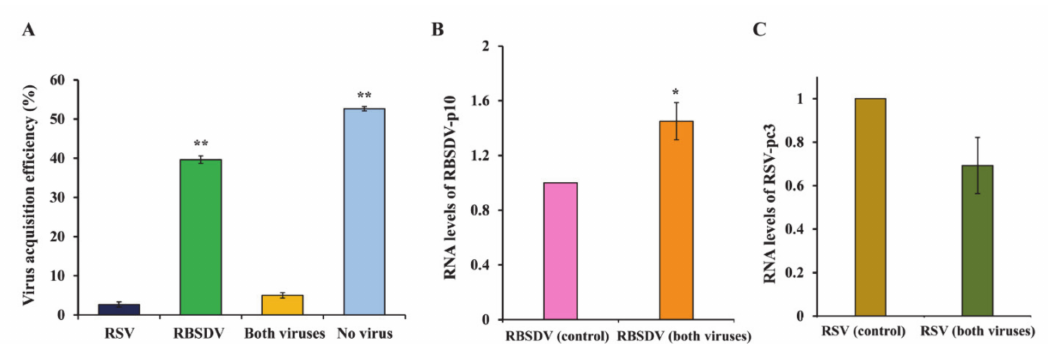
Figure 6. Acquisition and accumulation of RSV and RBSDV after 3-day acquisition during a period of access to a plant coinfected with the two viruses. ( A ) Acquisition efficiency of RSV and RBSDV. Relative expression levels of ( B ) RBSDV-p10 and ( C ) RSV-pc3. Three biological replicates were performed; each had three technical replicates. Asterisks indicate a significant difference at (**) p < 0.01 and (*) p < 0.05, according to Tukey HSD test with 95 % confidence. Asterisks indicate a significant difference at (**) p < 0.01 and (*) p < 0.05 in Tukey’s HSD test with 95%